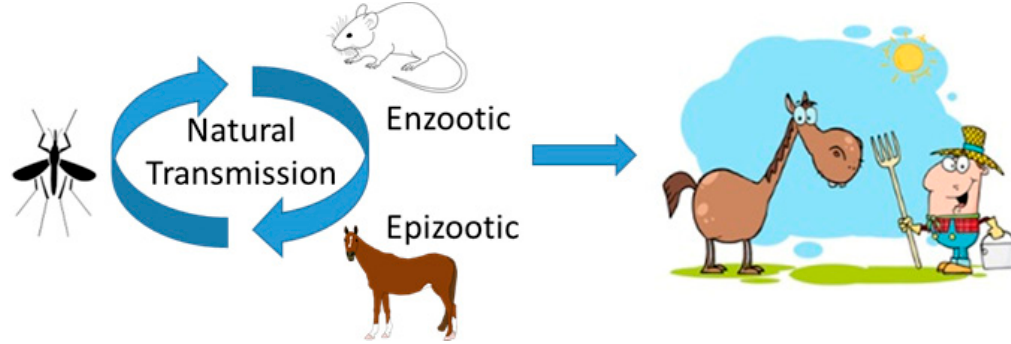
Figure 1. Venezuelan equine encephalitis virus (VEEV) transmission. VEEV is transmitted by a variety of mosquitoes. Enzootic strains are maintained in a cycle between small rodents and mosquitoes. Epizootic strains are transmitted by mosquitoes to equines, causing high titer viremia and high mortality. The virus is tangentially transmitted by mosquitoes from equines to humans that work in close contact with